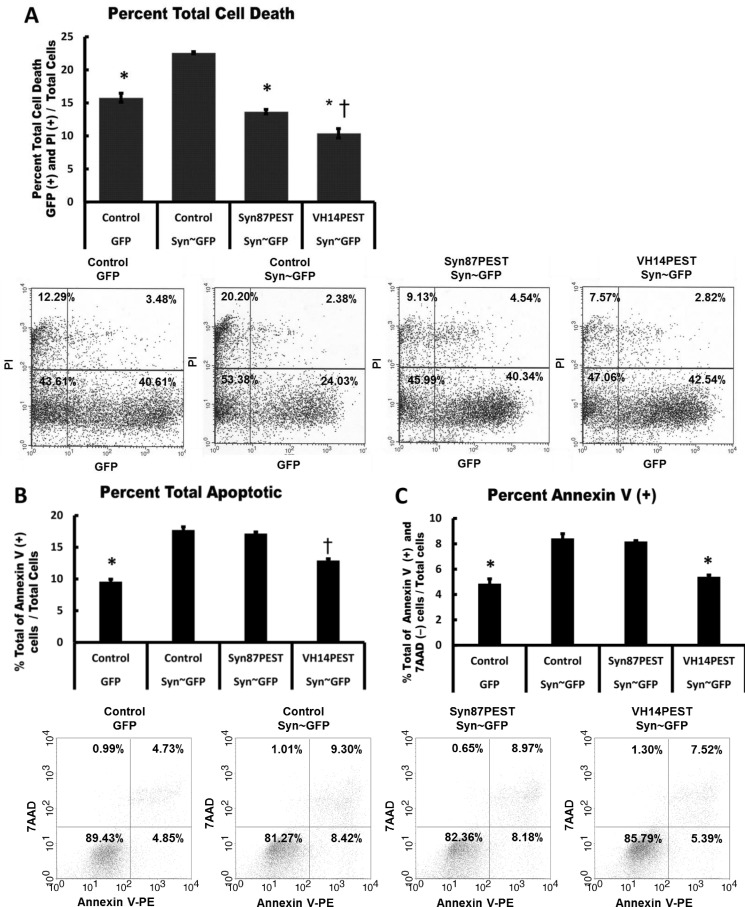
Overexpression of Syn87PEST and VH14PEST reduced total cell death to control levels in ST14A cells.(A) VH14PEST reduced the percentage of total cell death to a greater extent than Syn87PEST. [Mean ± SEM. * p<0.05 compared to Syn-GFP; † p<0.05 compared to Syn87PEST; n = 3]. (B & C) Representative scatter plots showing the percentage of cells in each quadrant. Viable cells are annexin V (−) and 7-AAD (−); annexin V (+) and 7-AAD (−) cells are in early apoptosis; annexin V (+) and 7-AAD (+) cells are in late apoptosis; necrotic cells are annexin V (−) and 7-AAD (+). (B) The percent total of cells undergoing late apoptosis was significantly reduced by VH14PEST compared to empty vector control co-transfected GFP levels. (Mean ± SEM. *p<0.05 comparing control GFP, to other groups; ᵻ p<0.05 compared VH14PEST/SYNGFP to other groups; n = 3). (C) The percent Annexin V positive cells undergoing early apoptosis was significantly reduced to empty vector control co-transfected GFP levels. (Mean ± SEM. *p<0.05 comparing control GFP, VH14PEST Syn-GFP to other groups; n = 3).